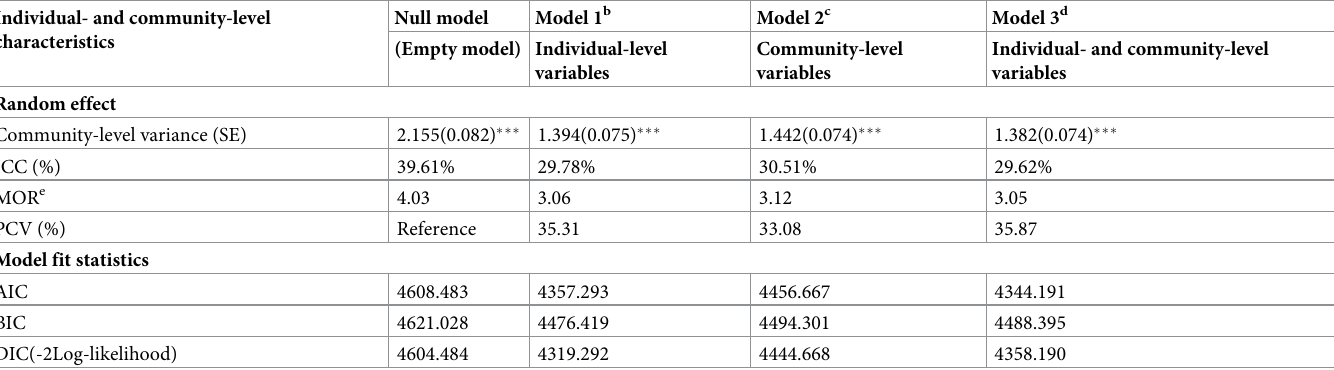
Table 5. Measures of variation (random intercept models) and model fit statistics for unsafe child stool disposal in Ethiopia, EDHS 2016. Individual- and community-level